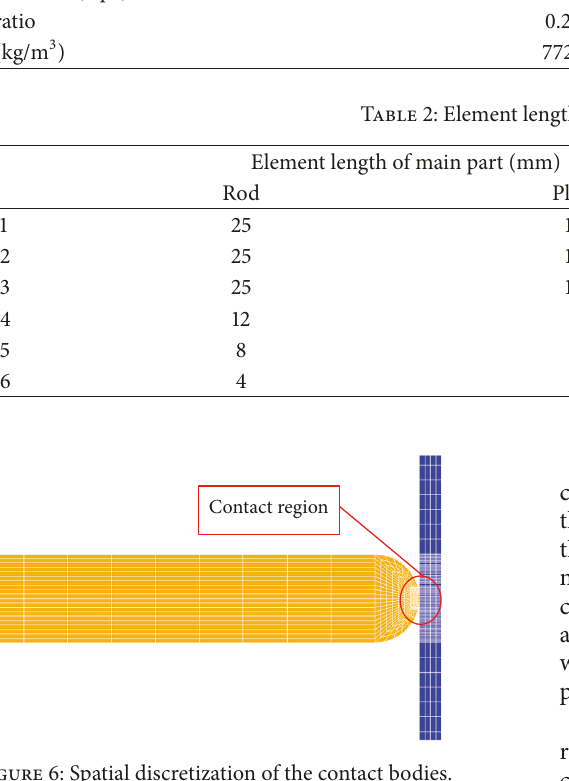
the required maximal element size of the rod is 25 mm, and the plate is 15